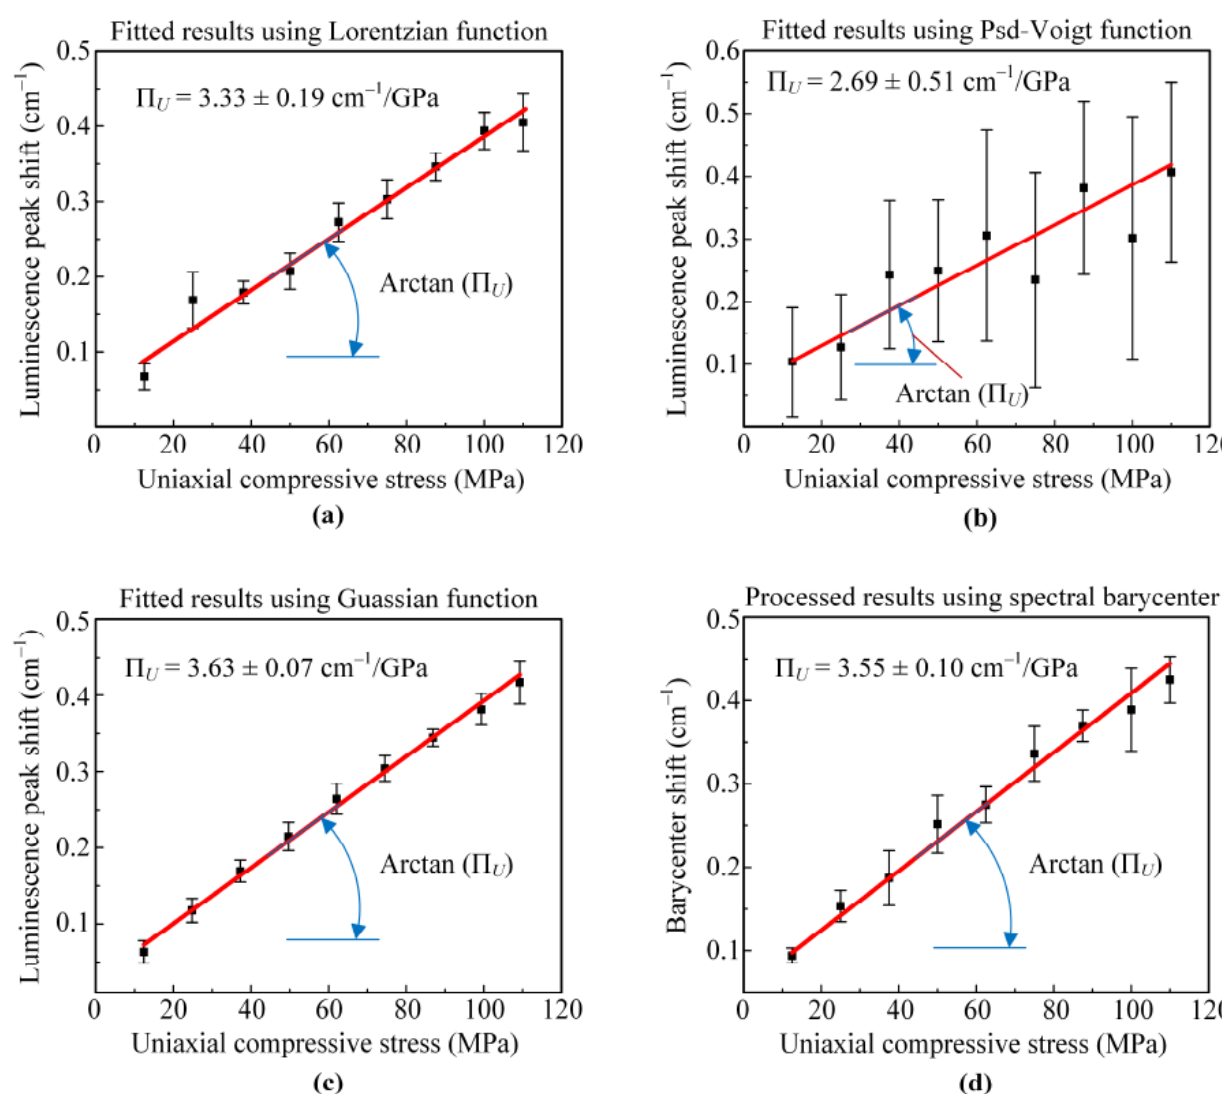
Figure 8. The relationships between uniaxial compressive stress and luminescence peak shift of measured spectra obtained with different processing methods. ( a ) Lorentzian fitting; ( b ) Psd-Voigt fitting; ( c ) Gaussian fitting; ( d ) Barycenter method. Table 4. Piezospectroscopic coefficients П U from calibration experiments, obtained with different data processing methods.